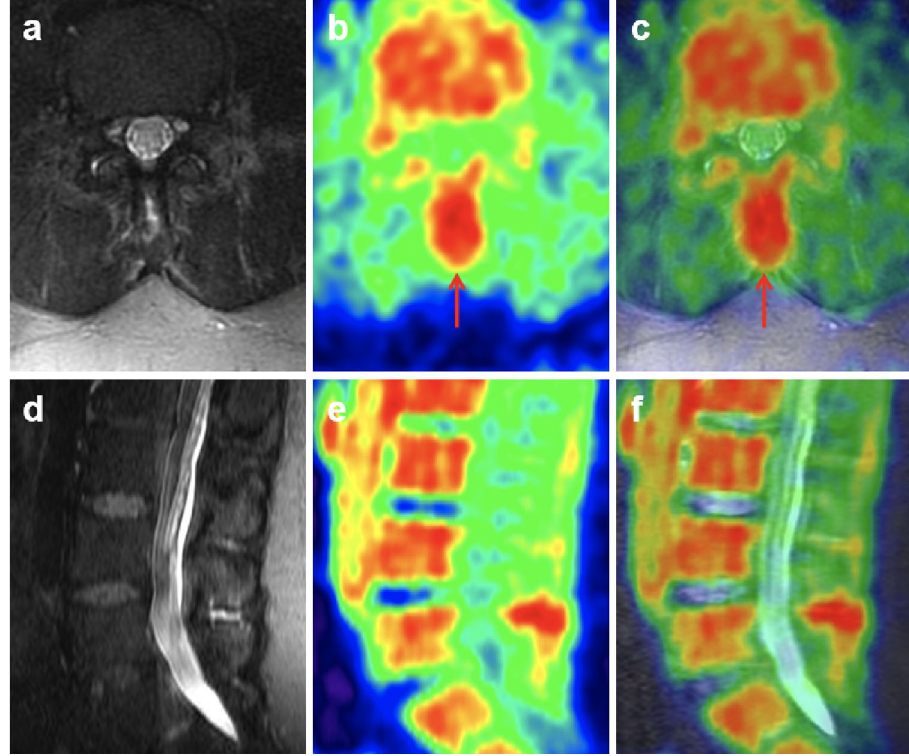
Figure 2. [18F]FDG PET/MRI abnormalities at L4-5 at level of interspinous ligament of patient with suspected cerebrospinal fluid leak, not observed on conventional MRI. High resolution axial MSDE-UBE MRI ( a ) shows increased signal in the vicinity of the interspinous ligament and paraspinal muscles, which was not observed in the original conventional lumbar spine MRI the patient had recently before this PET/MRI. Axial [18F]FDG PET ( b ) and PET/MRI ( c ) shows increased radiotracer uptake posterior to the spinal canal in the region of the interspinous ligament (red arrow, SUV max 3.25). Sagittal reformats of the MSDE-CUBE MRI, PET, and PET/ MRI are shown in ( d ), ( e ), and ( f ), respectively to help appreciating the abnormally increased uptake in this level compared to those in other